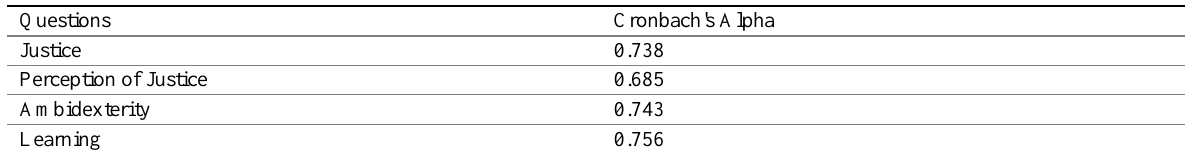
Table 2: Cronbach's Alpha (Reliability)